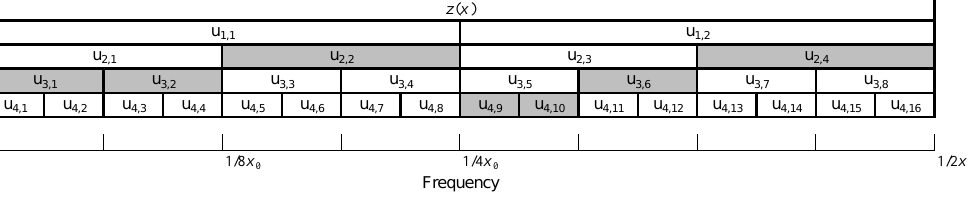
Fig. 2. The MODWPT decomposition of a series z(x) , where x = 1 , 2 ,...,N up to level j = 4. The nominal frequency ranges associated with each WP filter u j , m are shown. The darker shaded wavelet packets are an example of a complete